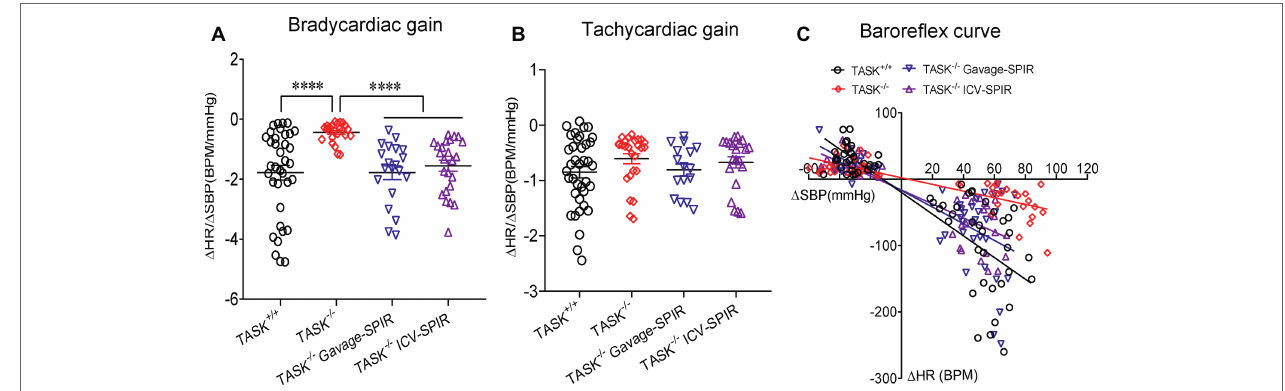
FIGURE 7 | Impairment of baroreflex gain in TASK − / − mice. The baroreflex gain was calculated based on the change in SBP ( Δ SBP) and HR ( Δ HR) during intravenous injection of PE (10 and 20 μ g/kg) and during intravenous injection of SNP (30 and 60 μ g/kg) in TASK +/+ mice ( n = 18 mice/70 responses), TASK − / − mice ( n = 12 mice/50 responses), TASK − / − mice with gavage of SPIR ( n = 10 mice/48 responses), and TASK − / − mice with ICV injection of SPIR ( n = 12 mice/45 responses), respectively. (A,B) Bradycardiac rather than tachycardiac gain was significantly decreased in TASK − / − mice relative to TASK +/+ mice. **** p < 0.0001 as indicated by Kruskal-Wallis test followed by Dunn’s multiple comparisons test. (C) The baroreflex curve showing individual data points for the change in heart rate ( Δ HR) in response to induced changes in SBP ( Δ